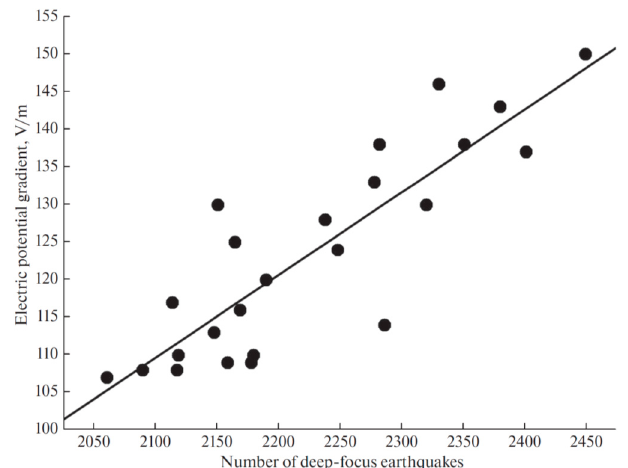
Figure 8. Distribution of hourly values of the potential gradient in the fair-weather electric field (Carnegie curve according to the data from 1915–1921) with respect to the hourly values of the number of deep-focus earthquakes h ≥ 71 km with a magnitude of M ≥ 4.5, according to the NEIC global seismological catalog for 1973–2017.